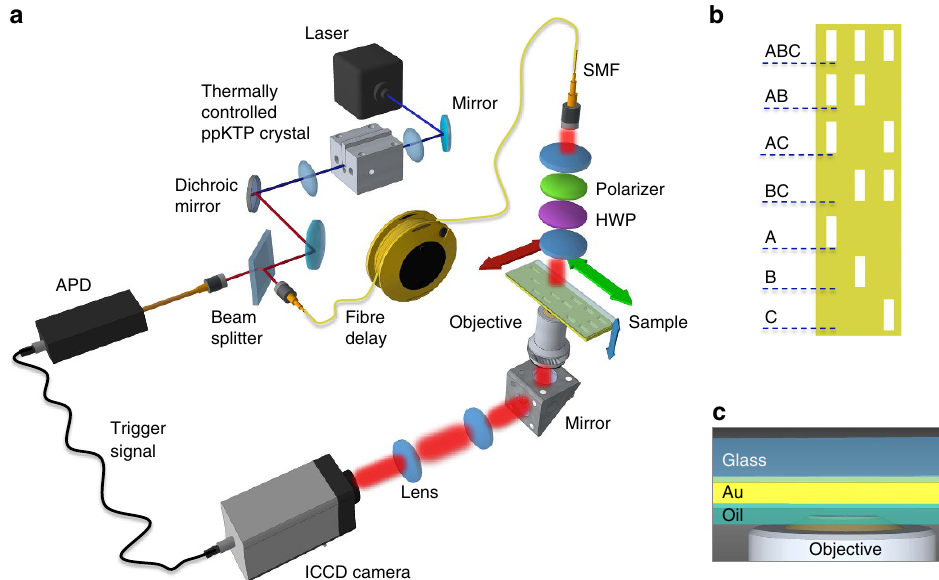
Figure 2 | Experimental set-up utilized to measure exotic trajectories of light. ( a ) Sketch of the experimental set-up used to measure the far-field interference patterns for the various slit configurations. ( b ) The seven different slit arrangements used in our study. This drawing is not to scale; in the actual experiment each slit structure was well separated from its neighbors to avoid undesired cross talk. ( c ) Detail of the structure mounted on the set-up. The refractive index of the immersion oil matches that of the glass substrate creating a symmetric index environment around the gold